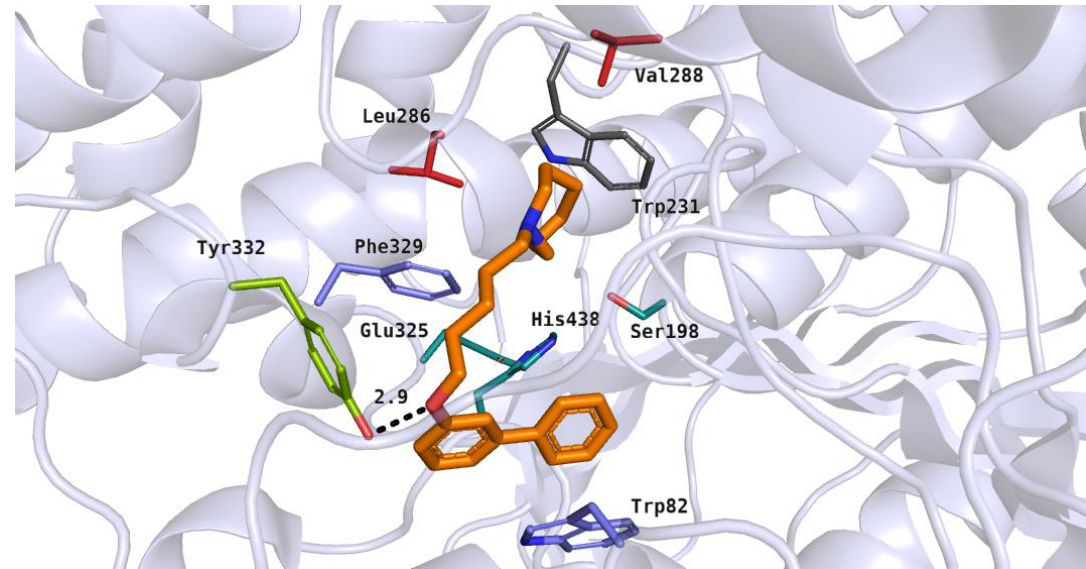
Figure 9. Binding mode of compound 20 within the butyrylcholinesterase active site. Residues colored in teal represent the catalytic triad, blue — anionic site, green — peripheral anionic site, red — acyl pocket.